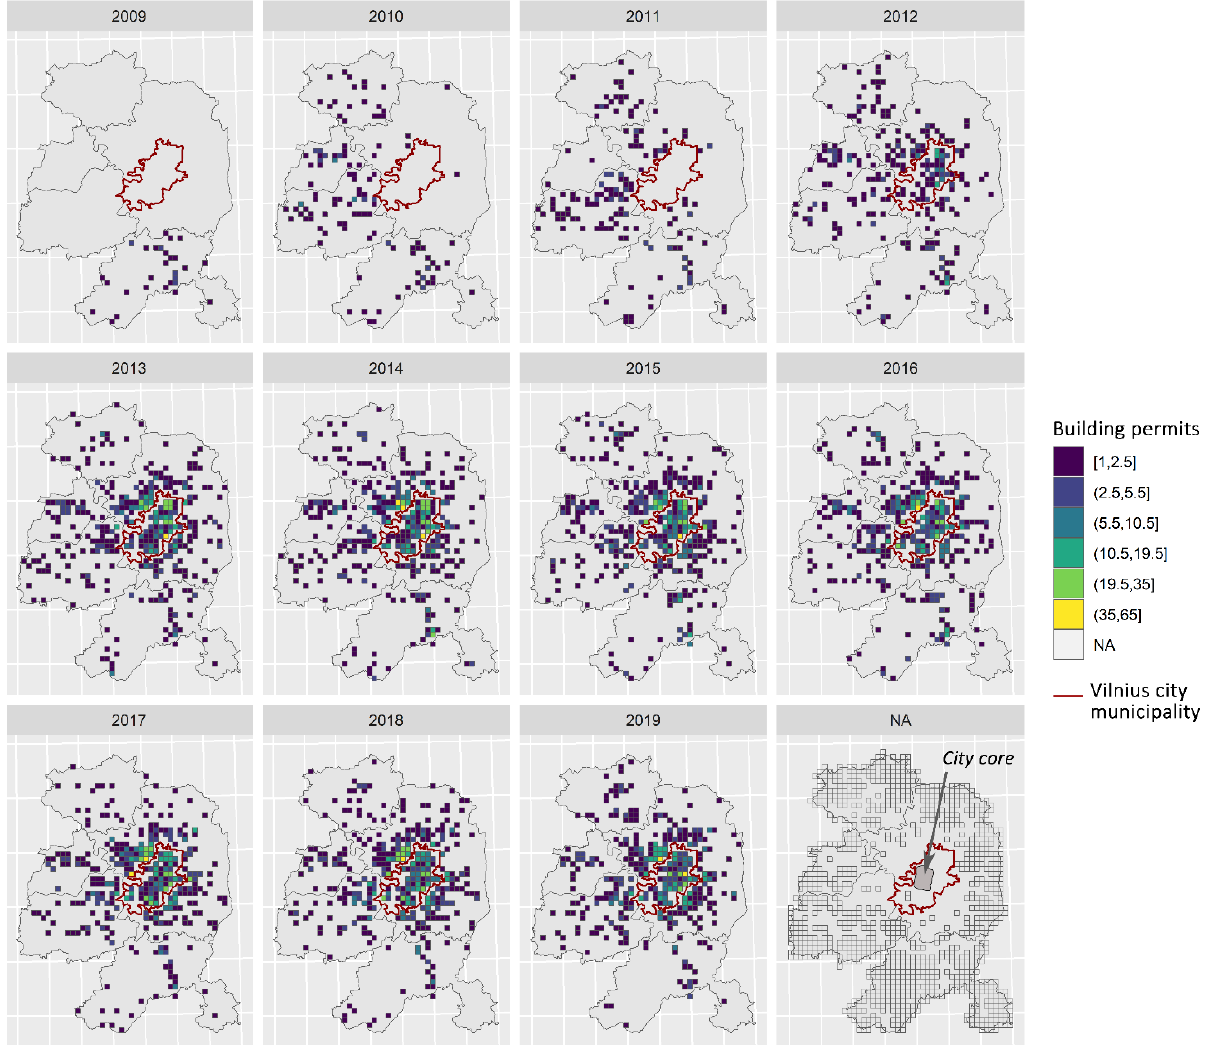
Fig. 2. The number of building permits issued in the Vilnius metropolitan area for detached and semi-detached family houses in 2009–2019; 2 km x 2 km grid (Source: own elaboration based on “Infostatyba”